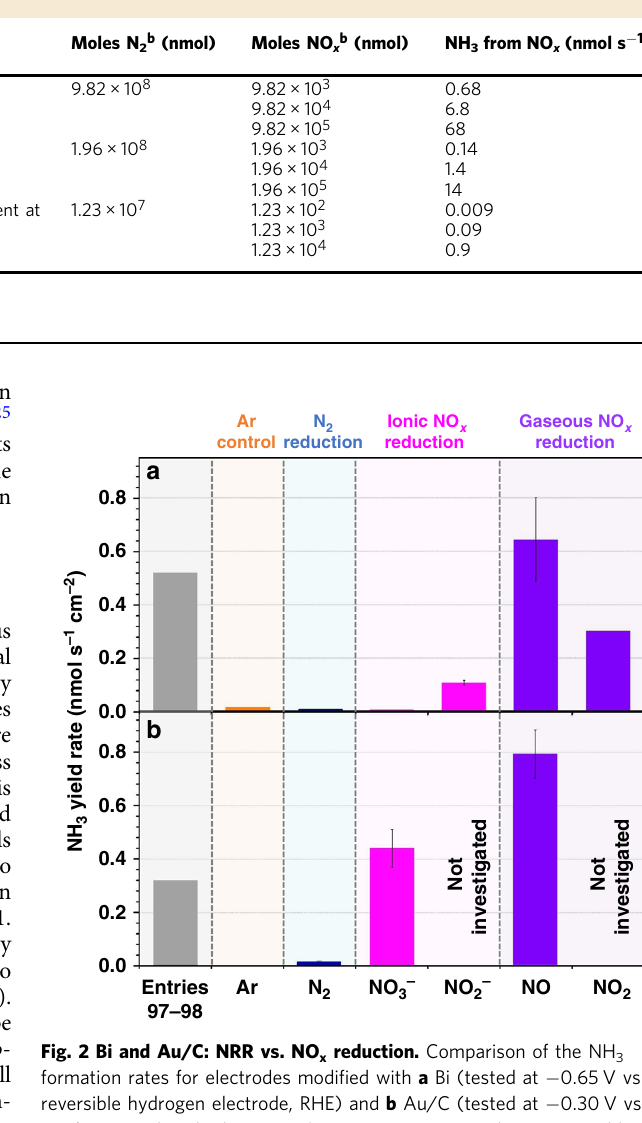
Table 1 Amount of N 2 and potential NO x contaminants supplied in 4-h a NRR experiments undertaken at different gas supply rates.